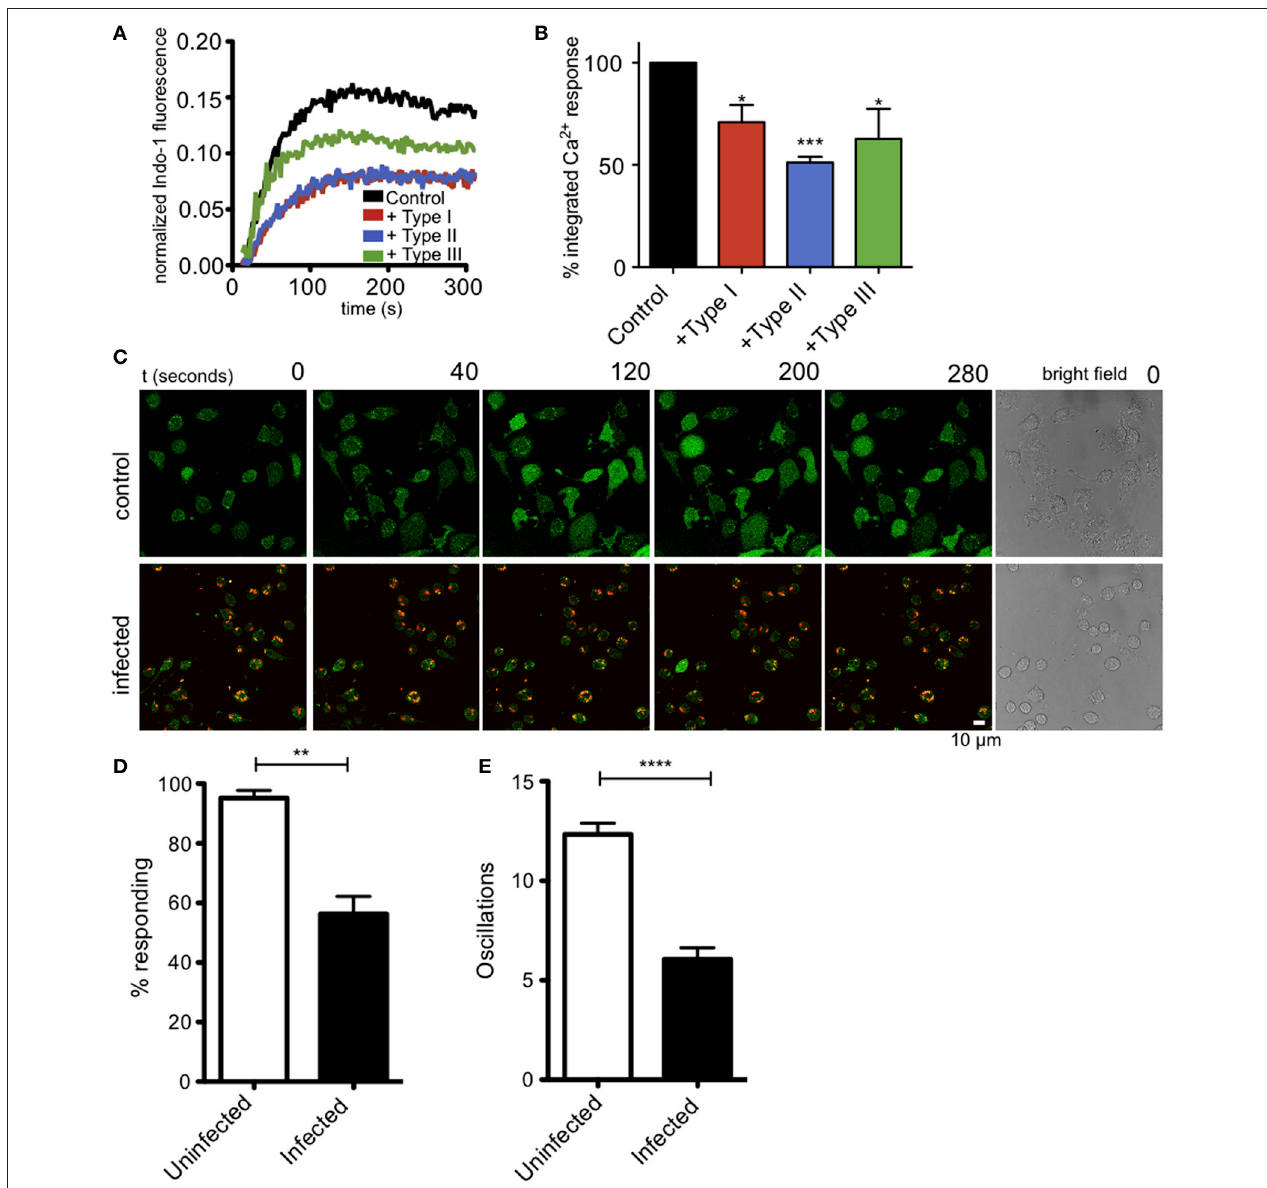
3–5 independent experiments. (C) Live Fluo-4 (green) Ca 2 + imaging in uninfected or RH-tomato (red) infected RBL-cells. (see supporting movies M2 and M3). Quantification of the percentage of responding cells (D) or average number of Ca 2 + oscillations per cell in 10min (E) in live Ca 2 + imaging experiments ( n = 174 cells over 3 experiments). Error bars represent SEM ( ∗ P < 0 . 05, ∗∗ P < 0 . 01, ∗∗∗ P < 0 . 001, and ∗∗∗∗ P < 0 . 0001 relative to uninfected